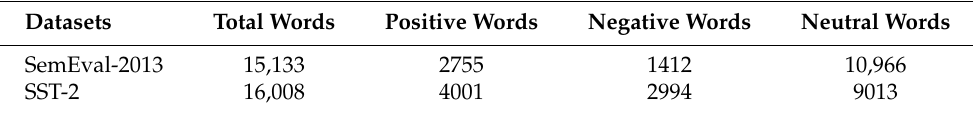
Table 3. The numbers of sentiment words in SemEval-2013 and